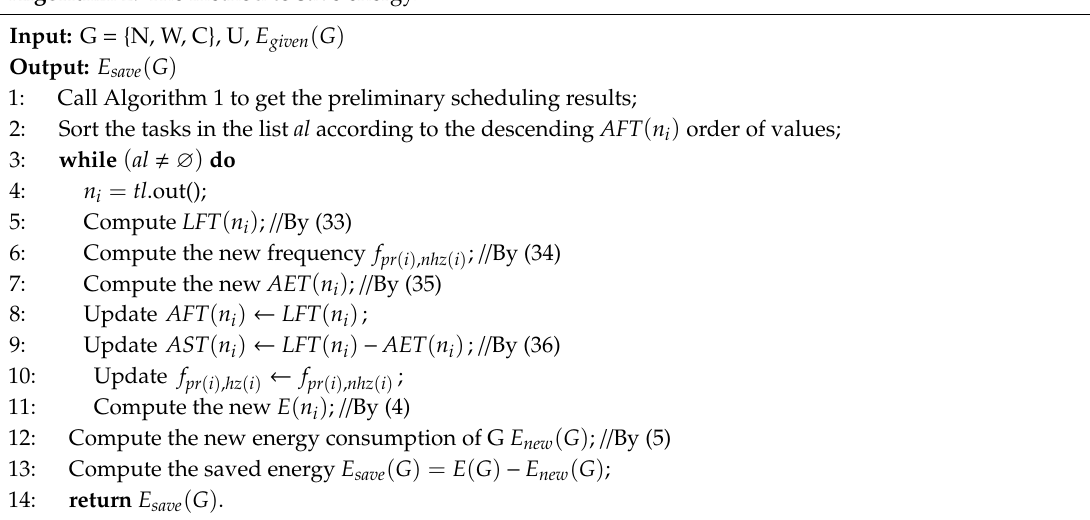
Algorithm 2. The method to save